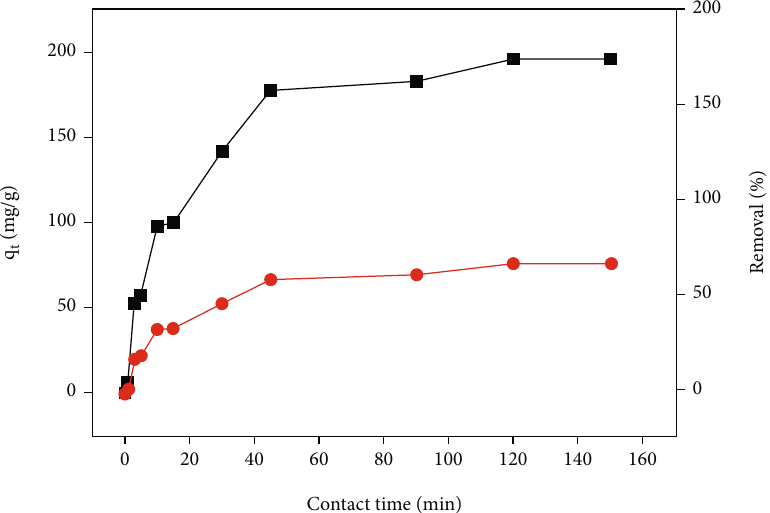
Figure 6: The contact time e ff ect (condition: initialMGconcentration = 0 : 03 mg · L − 1 , dosage of adsorbent used = 0 : 15g · L − 1 , temperature = 303 : 15K , and shakingspeed = 200rpm